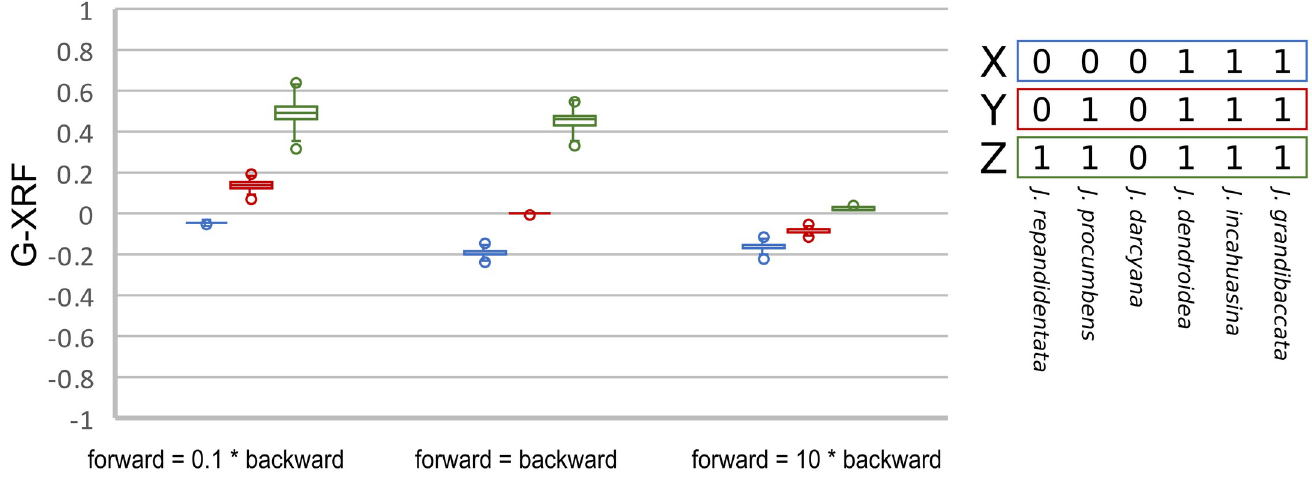
Fig 6. G-XRF values of three trait patterns (X, Y and Z) as the ratio of forward to backward substitutions is varied. Each box plot summarizes 3,000 G-XRF values obtained from the species network and corresponding major tree sampled from the posterior distribution of Jaltomata species networks.